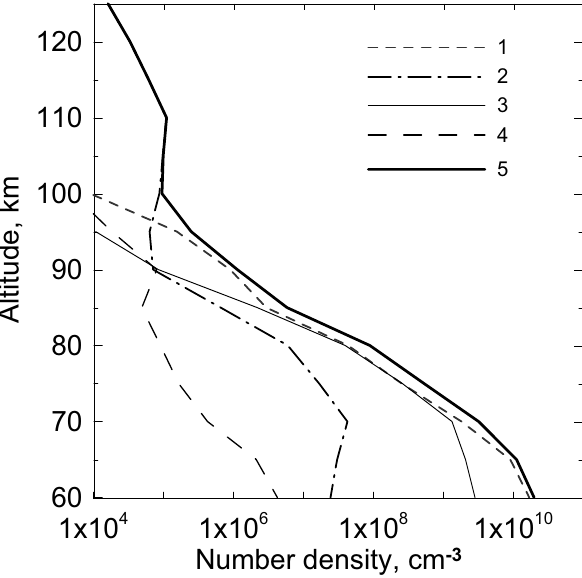
Fig. 5. Areas of diagram indicate the relative contributions of direct and indirect processes to the total rate of O 2 (a 1 1 g , v=0) produc- tion, in percent. Direct processes: 1 – absorption of solar radia- tion O 2 + h ν (1.27 µ m) → O 2 (a 1 1 g , v=0); 2 – ozone photolysis in the Hartley band O 3 + h ν → O 2 (a 1 1 g , v=0). Indirect processes: 3 – ozone photolysis in the Hartley band O 3 + h ν → O 2 (a 1 1 g , v ≥ 1); 4 – energy transfer O( 1 D) → O 2 (b 1 6 + g , v) → O 2 (a 1 1 g , v).